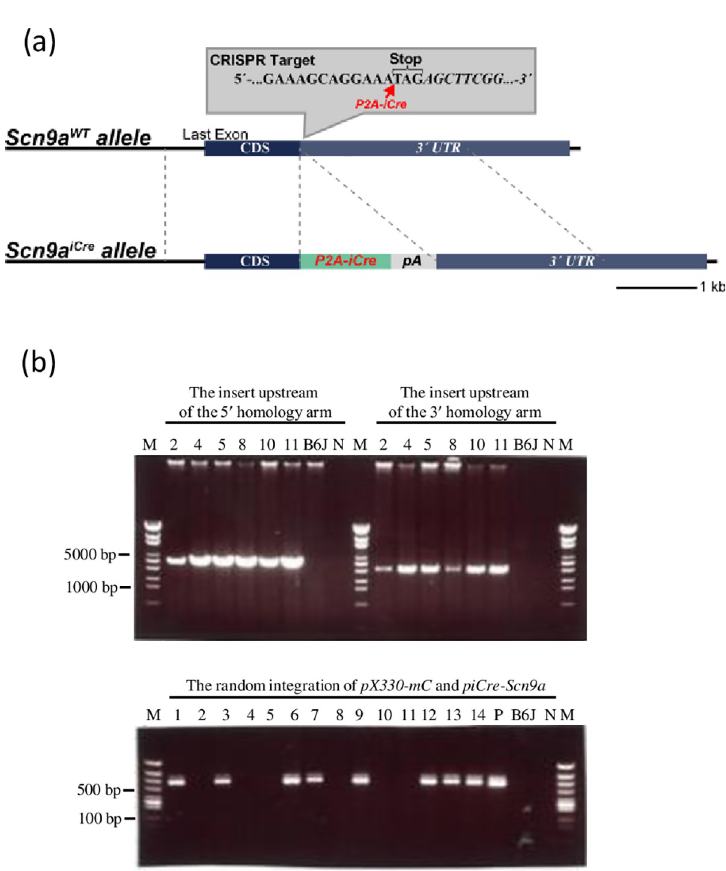
Fig 1. Schematic diagram of the Scn9a iCre knock-in allele (a) and PCR for genotyping founder mice (b). (a)The last exon of Scn9a is illustrated. The P2A-iCre sequence was inserted immediately after the stop codon of Scn9a . (b) The detection of the insert upstream of the 5 0 - and 3 0 -homology arm and the random integration of pX330-mC and piCre- Scn9a . Six founder mice were determined to carry the designed knock-in mutation. M, marker; P, positive control; N, negative control.